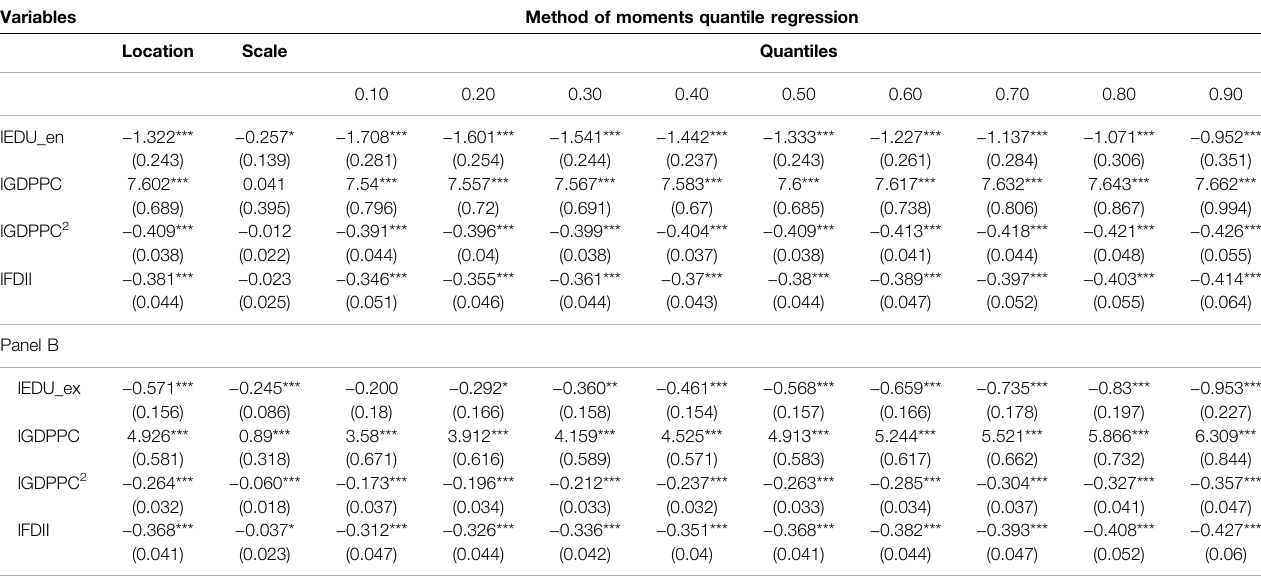
TABLE 7 | Method of moments quantile regression (MMQR) estimation results. Panel A Variables Method of moments quantile